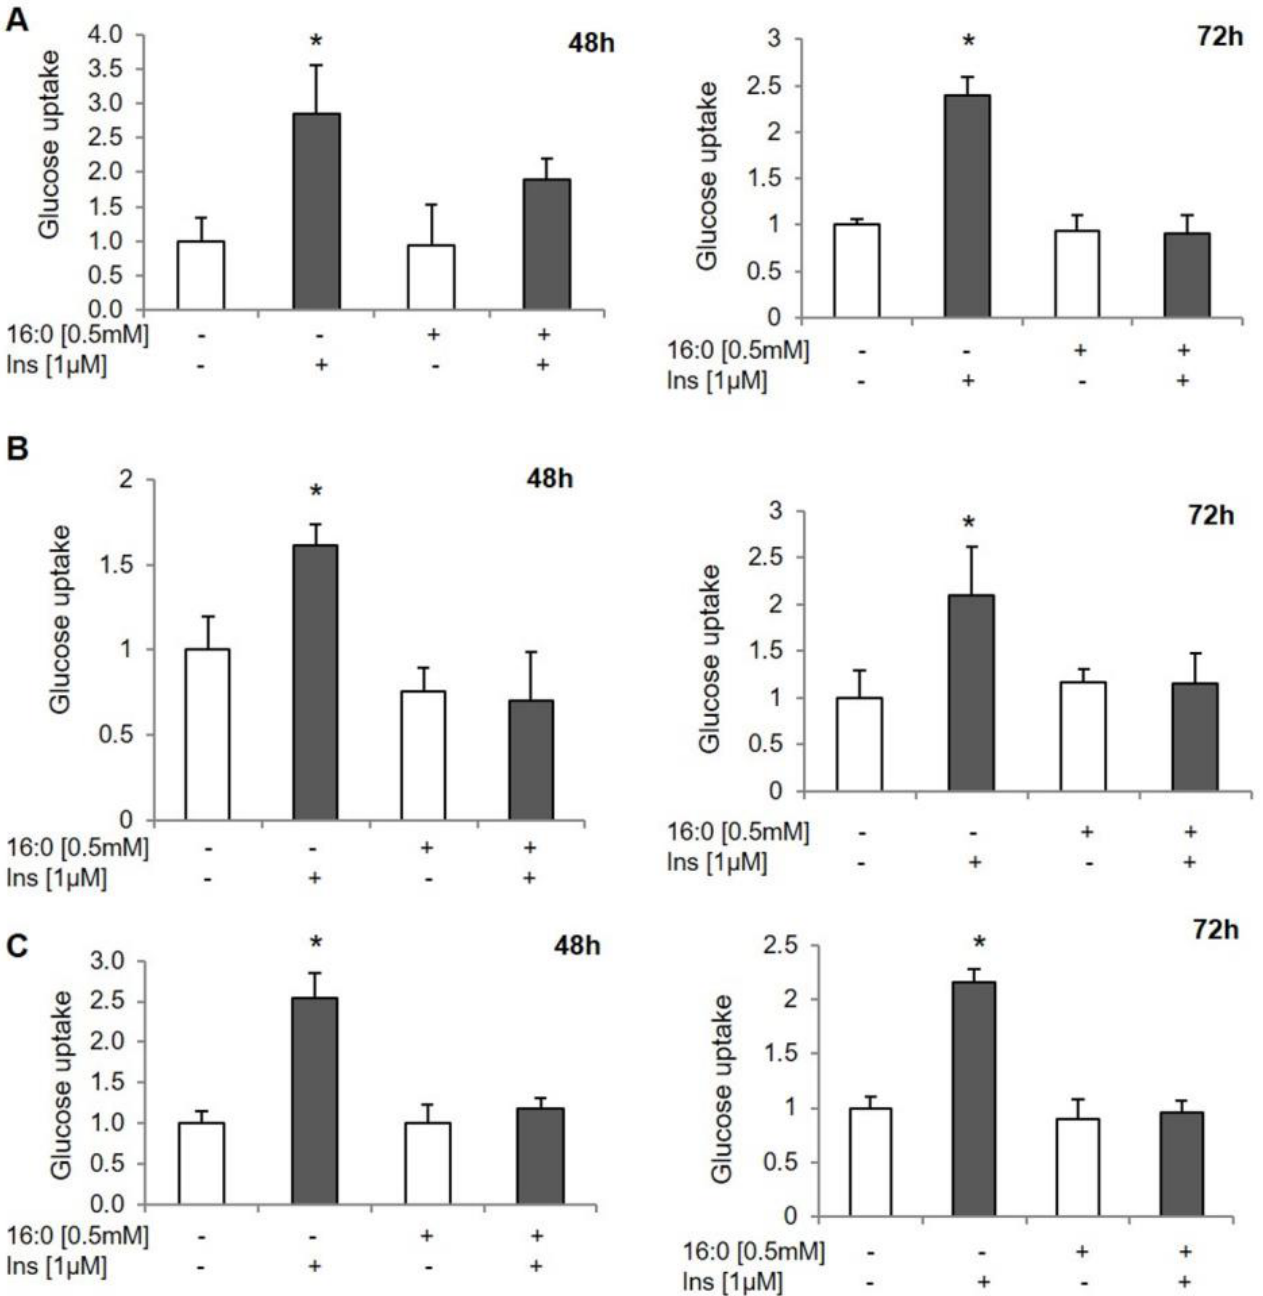
Figure 1. The assessment of insulin resistance in experimental adipocytes. The glucose uptake measurements in control and insulin-resistant adipocytes treated with 0.5 mM palmitic acid (16:0) for 48 h and 72 h: ( A ) 3T3-L1 adipocytes, ( B ) human SAT-derived adipocytes, ( C ) human adipocytes from VAT, INS − —basal glucose uptake, INS+—insulin-stimulated glucose uptake, * p < 0.05.